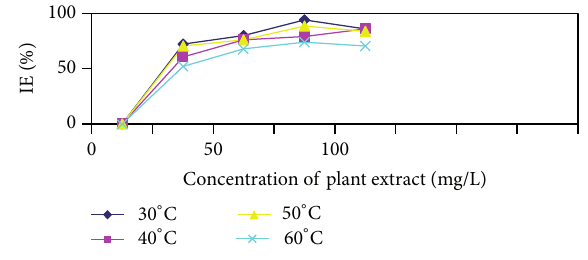
F 3: Inhibition efficiency of alkaloid extract of Trichodesma indicum at various